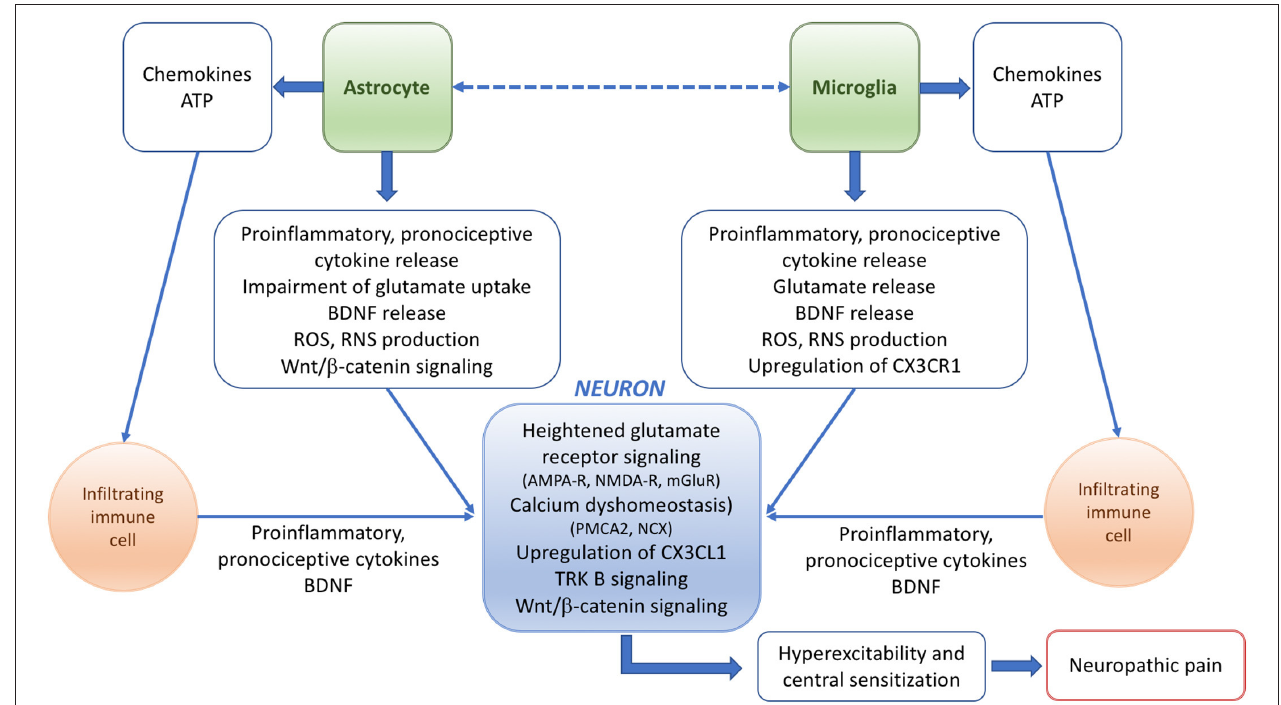
FIGURE 1 | Scheme summarizing the potential mechanisms and players underlying the pathophysiology of neuropathic pain in EAE or MS.